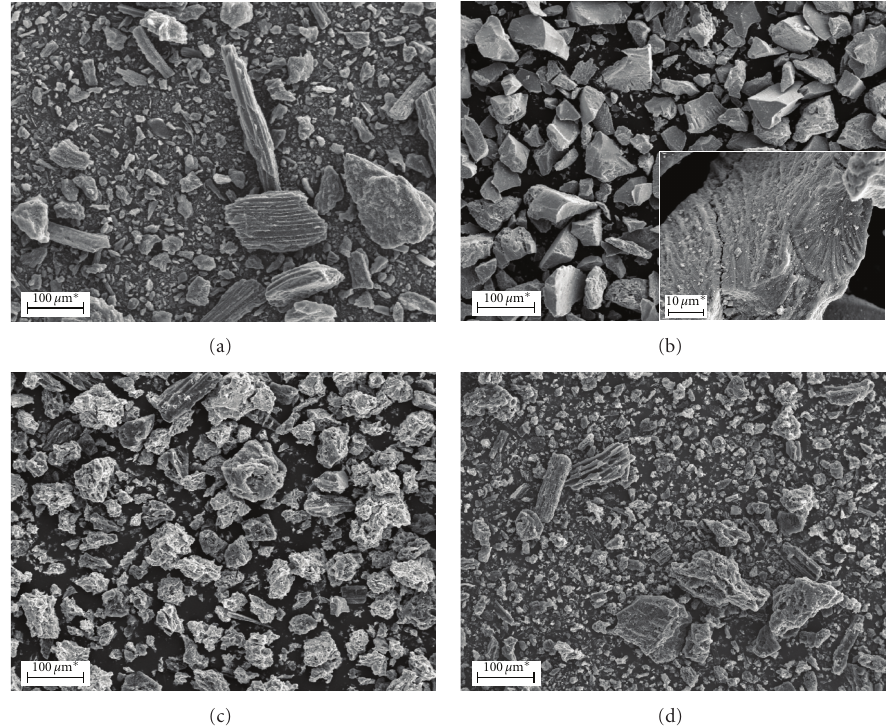
Figure 3: SEM images of (a) active carbon NORIT; (b) NiO; (c) composite W1; (d) composite W3.